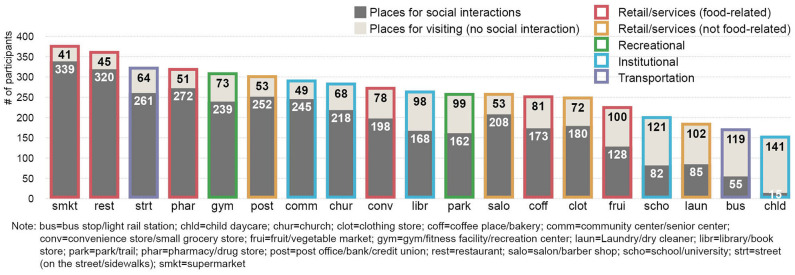
Places for visiting and social interactions at least once a week.